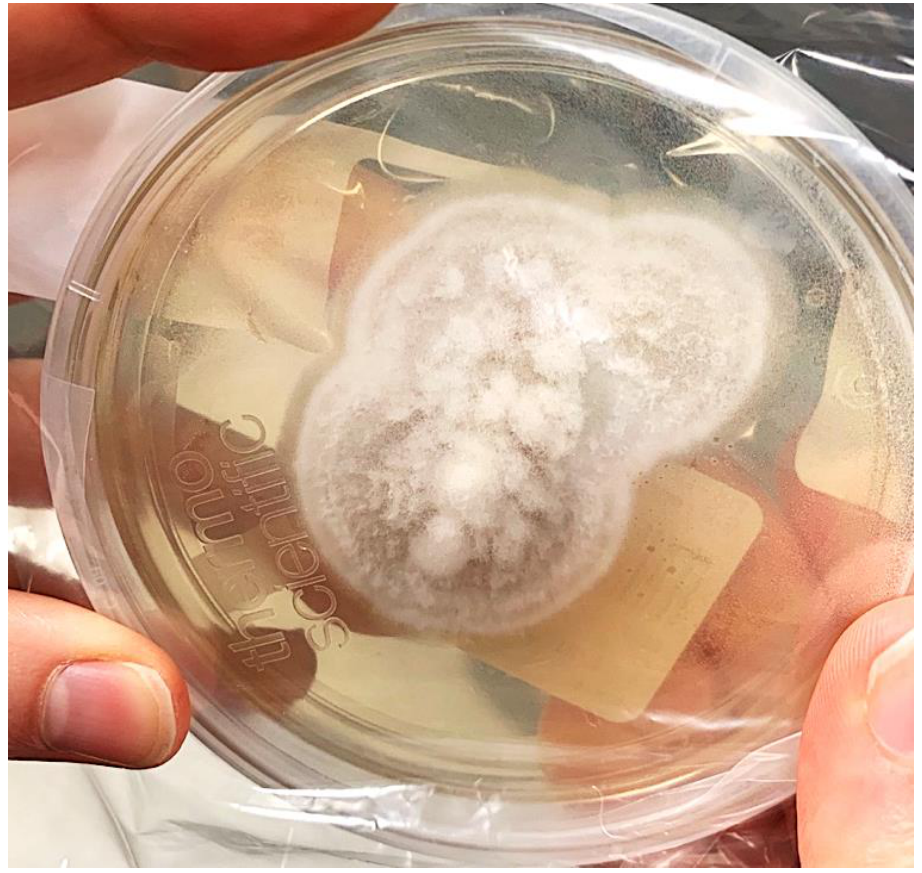
Figure 8. The typical white colonies of the mold form of Coccidioides on Sabouraud dextrose agar, which grew from the patient ’ s knee aspirate.